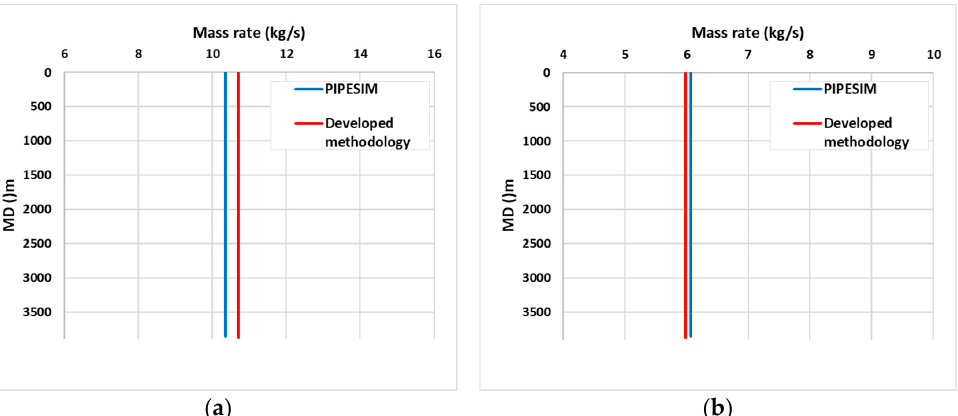
Figure 9. Mass gas flow rate distribution along the wellbore. The blue line represents the result of PIPESIM calculation, while the red line represents the result of calculation of the proposed model. The black oil model is ( a ), while the compositional model is ( b ).